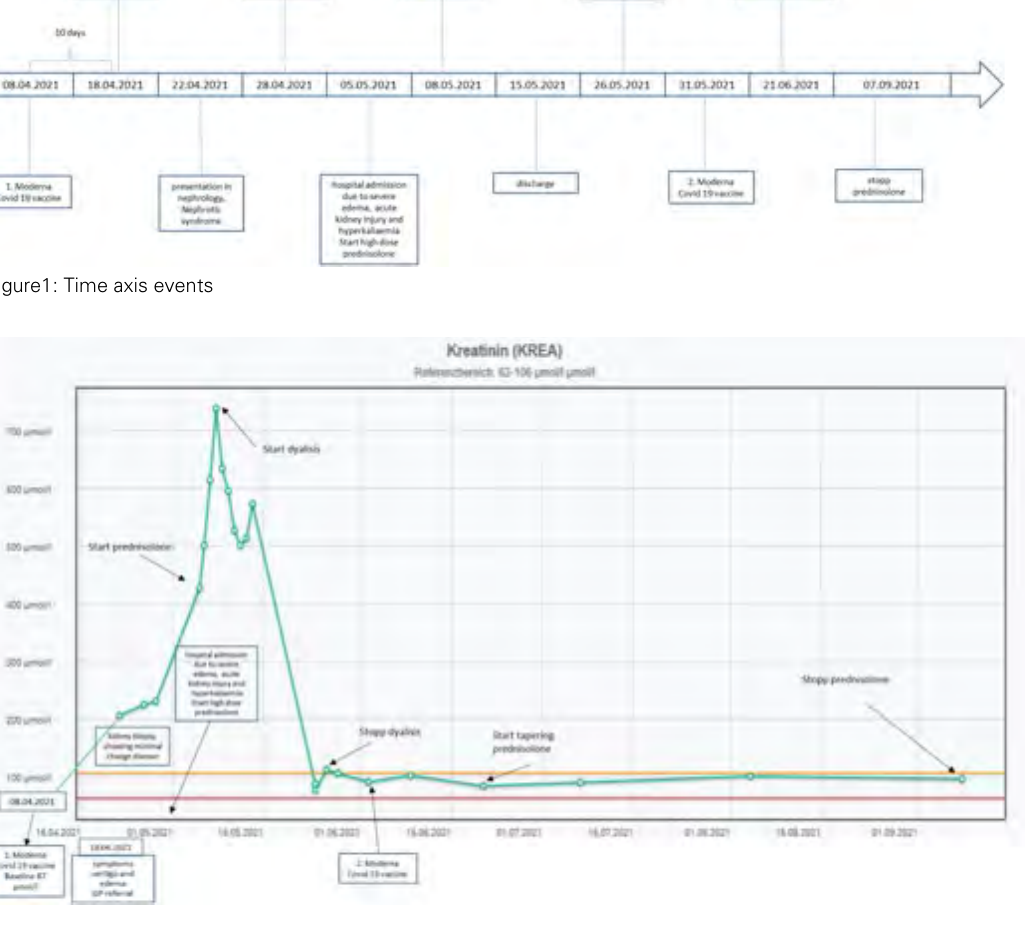
Figure 2: Time axis kidney function and